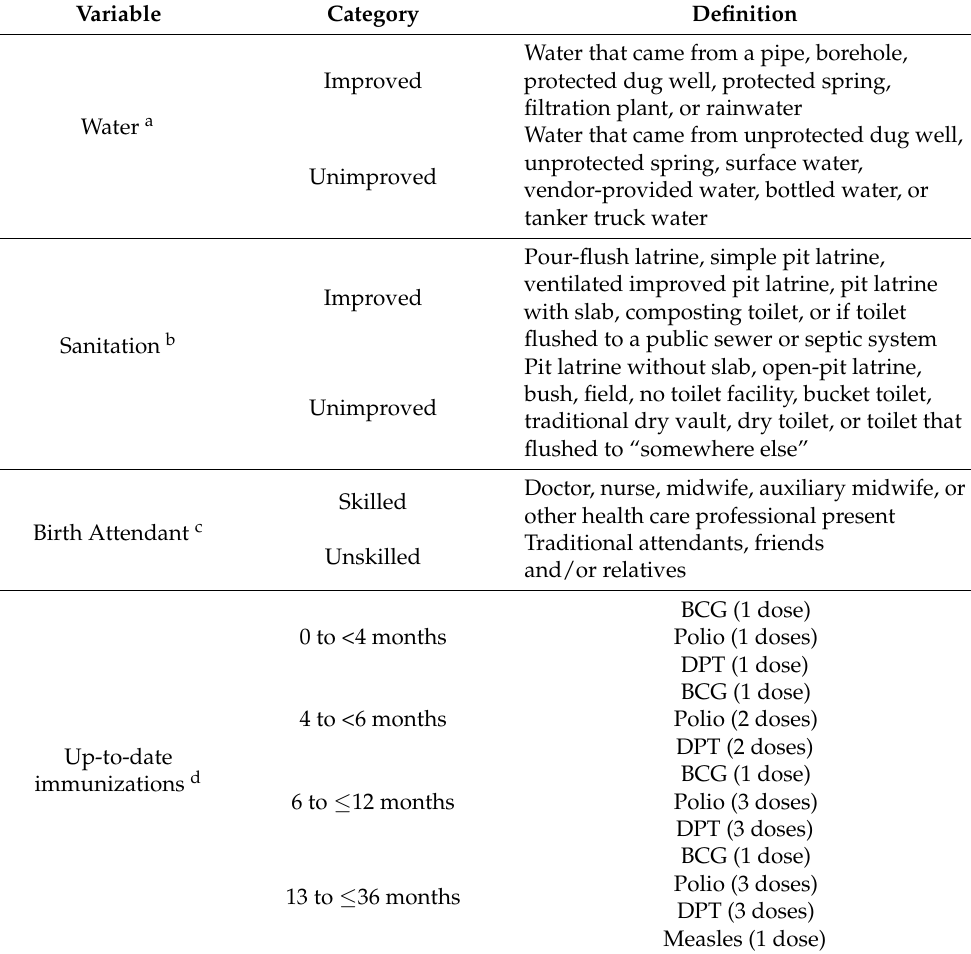
Table 1. WHO definitions applied to coding of